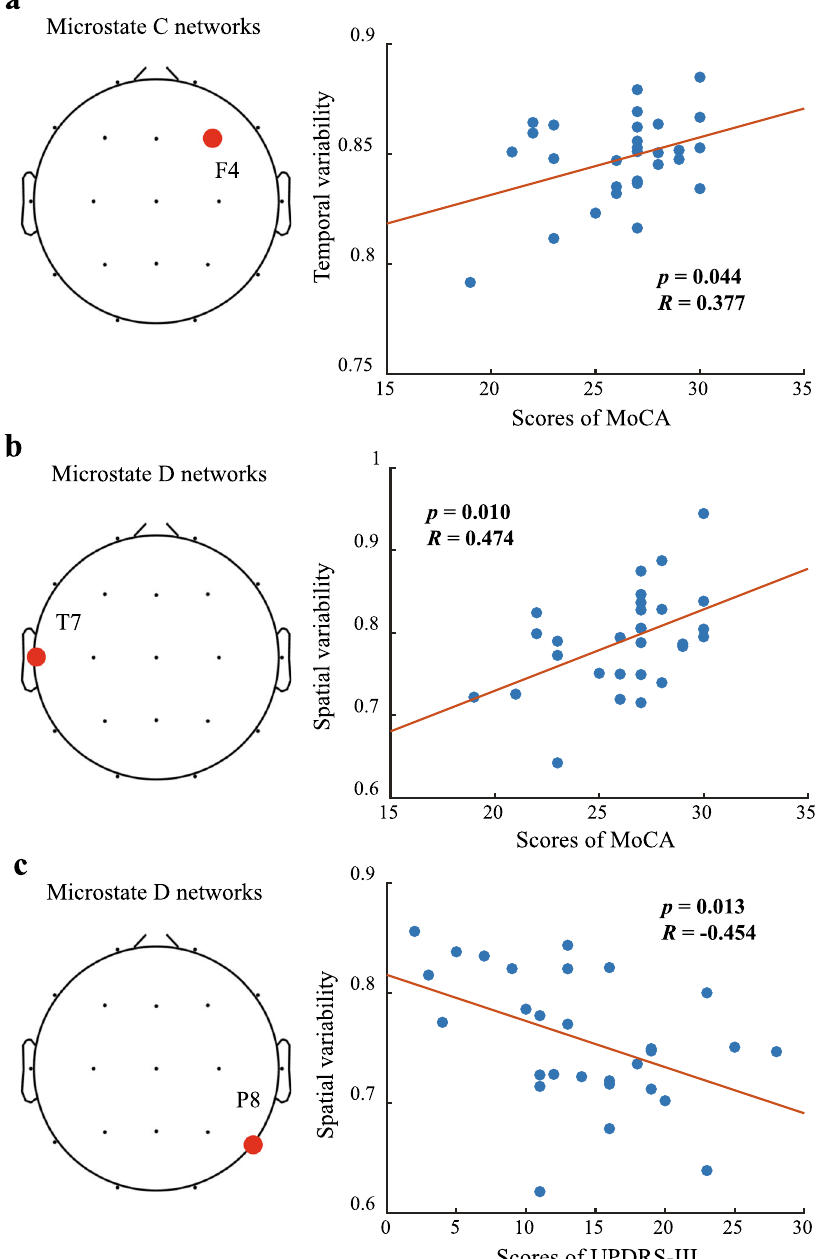
Fig. 5 Spearman ’ s correlation between scores of clinical scales and spatiotemporal variabilities of local scalp regions in microstate networks. a Spearman ’ s correlation between scores of MoCA and temporal variability of local scalp region at electrode channel ‘ F4 ’ . b Spearman ’ s correlation between scores of MoCA and spatial variability of local scalp region at electrode channel ‘ T7 ’ . c Spearman ’ s correlation between scores of UPDRS-III and spatial variability of local scalp region at electrode channel ‘ P8 ’ . The red point indicates the region in which the temporal and spatial variability of microstate brain networks in healthy controls are obviously higher than that in early PD patients. FDR correction was performed for p feature data, so that the accuracy of classi fi cation comes from the temporal and spatial variability calculated by our proposed contribution of the differences between the input characteristic method are relevant to the pathological changes in the brain of parameters. In addition, the data samples included in this work are early PD. small, so the binary task of processing small sample data has In this work, our research objective is to explore whether the become the selection criterion of the classi fi er in this work. spatial and temporal variability characteristics of dynamic brain Although there are various selection and optimization strategies networks based on EEG microstates can effectively identify early for machine learning classi fi ers at present, according to the PD patients compared with the conventional sliding window objective of this study, standard SVM with default parameters method. To address this, a classi fi er with fi xed parameters and con fi guration can meet the above requirements. Therefore, we relatively simple learning ability is needed for each type of input